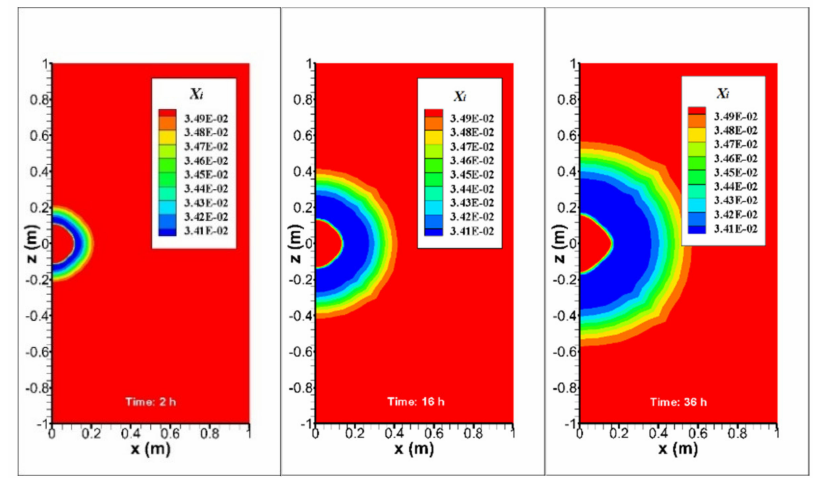
Figure 5. Salinity distribution evolution around the wellbore.